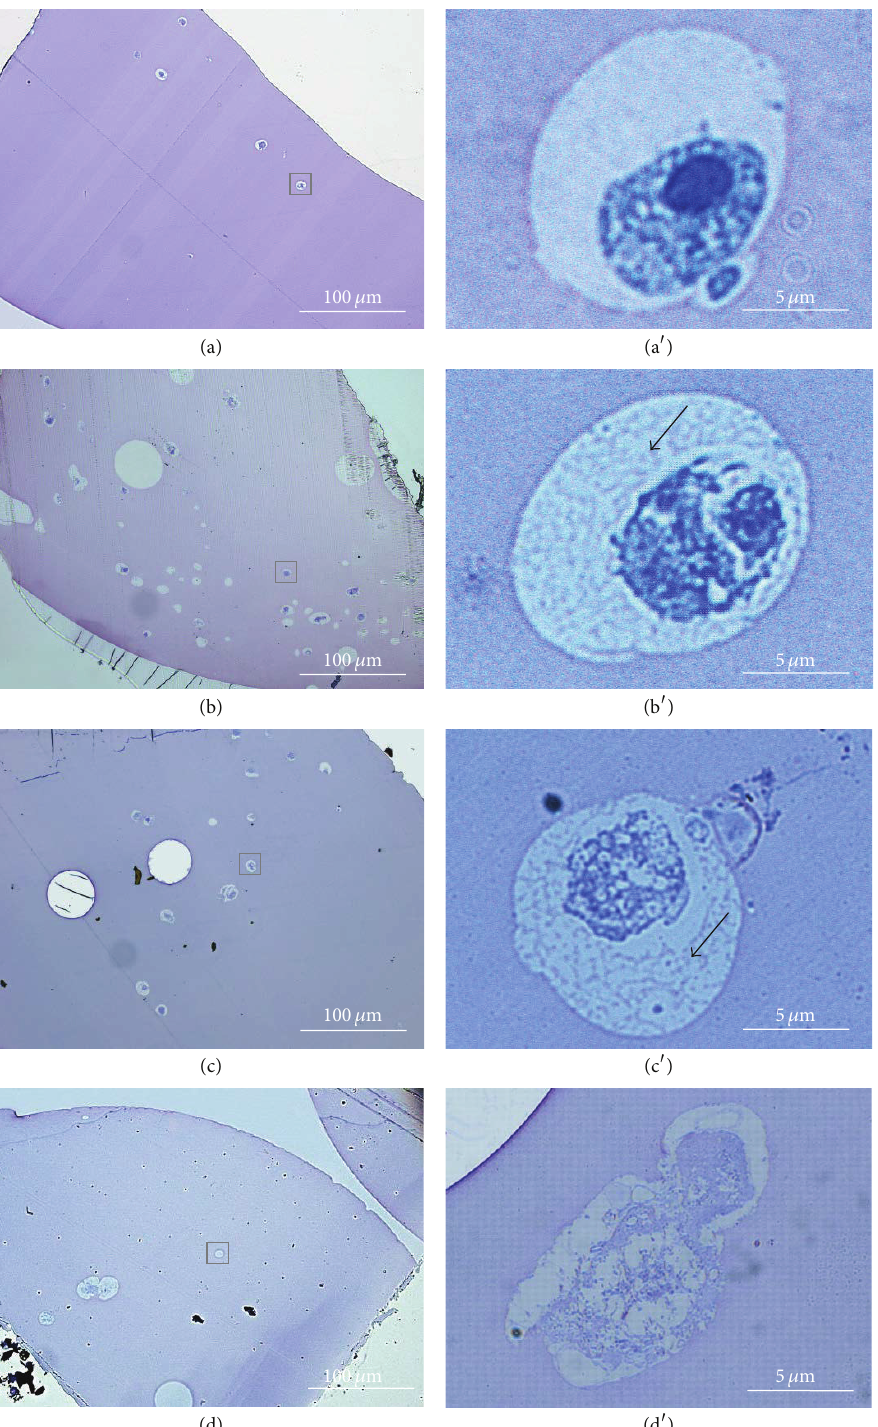
Figure 4: Microscopic images of hADSCs encapsulated within Ca/Co alginate beads at 21 days in culture and stained with toluidine blue. ((a), (a 󸀠 )) Co1.25 sample; ((b), (b 󸀠 )) Co2.5 sample; ((c), (c 󸀠 )) Co5 sample; and ((d), (d 󸀠 )) Co10 sample. Black arrows indicate proteoglycan matrix deposition. Black squares indicate